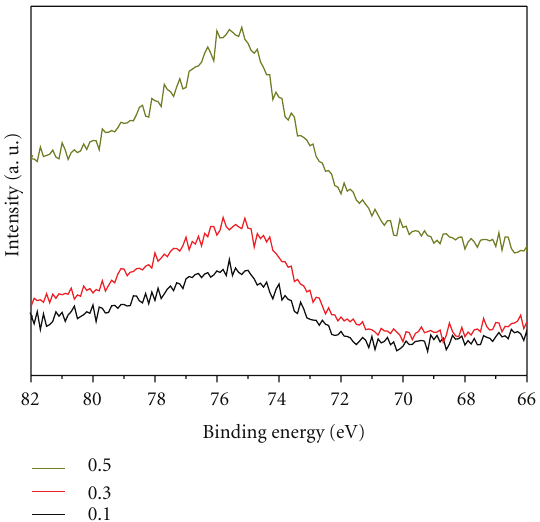
Figure 6: Al 2 p XPS spectra of TiO 2 produced at Al 2 O 3 /Ti mass ratio of 0.1, 0.3, and 0.5.